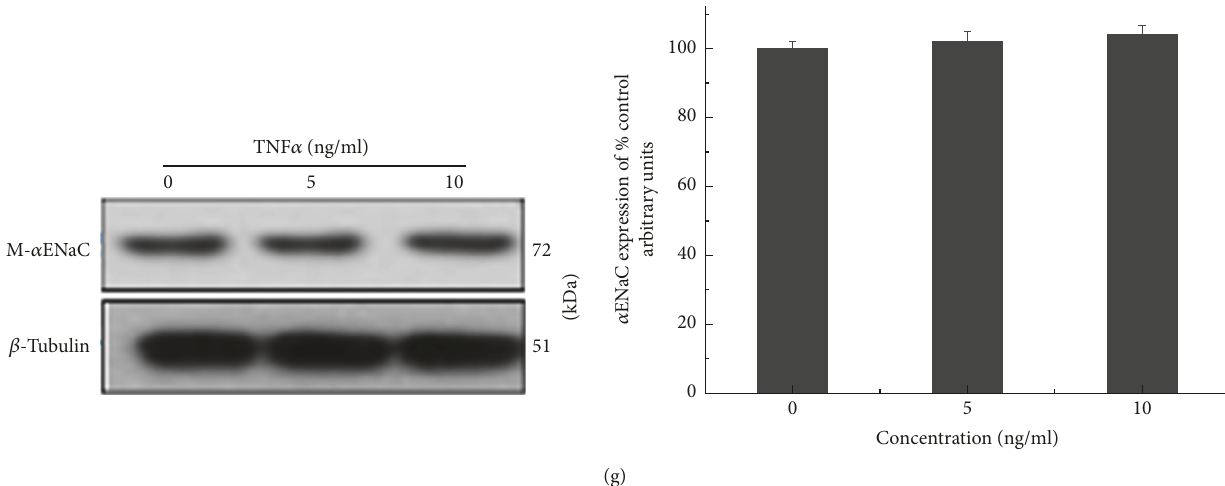
Figure 5: Effects of SR1664 and TNF 𝛼 on PPAR 𝛾 , p-PPAR 𝛾 , AQP2, and 𝛼 ENaC in mIMCD-3 cells. (a, c, d) The effects of SR1664 on PPAR 𝛾 , p-PPAR 𝛾 , AQP2, and 𝛼 ENaC. (b) The changes of PPAR 𝛾 and p-PPAR 𝛾 upon coincubation with GW9662 (10 𝜇 M SR1664 + 5 𝜇 M GW9662). (e–g) The effects of TNF 𝛼 on PPAR 𝛾 , p-PPAR 𝛾 , AQP2, and 𝛼 ENaC. The results show that SR1664 at 10 𝜇 M can significantly inhibit p-PPAR 𝛾 ; TNF 𝛼 even 5 ng/ml can critically increase p-PPAR 𝛾 , while there was no significant difference in the expression of AQP2 in cell membrane and cytoplasm and 𝛼 ENaC in membrane. After coincubation with GW9662 (10 𝜇 M SR1664 + 5 𝜇 M GW9662), the effect of SR1664 on p-PPAR 𝛾 disappeared. The results are shown as mean ± s.e.m., 𝑛 = 3 . ∗ 𝑃 < 0.05 . ∗∗/ ## 𝑃 < 0.01 . ∗ means compared to control; # means compared to